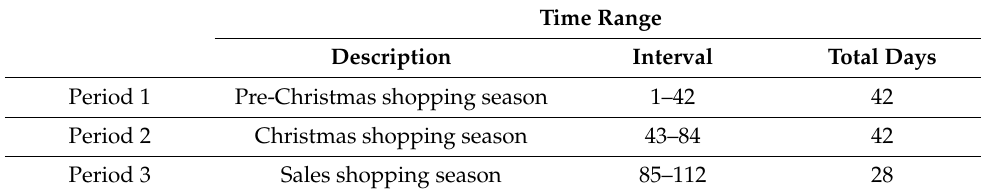
Table 8. Time period related parameters.